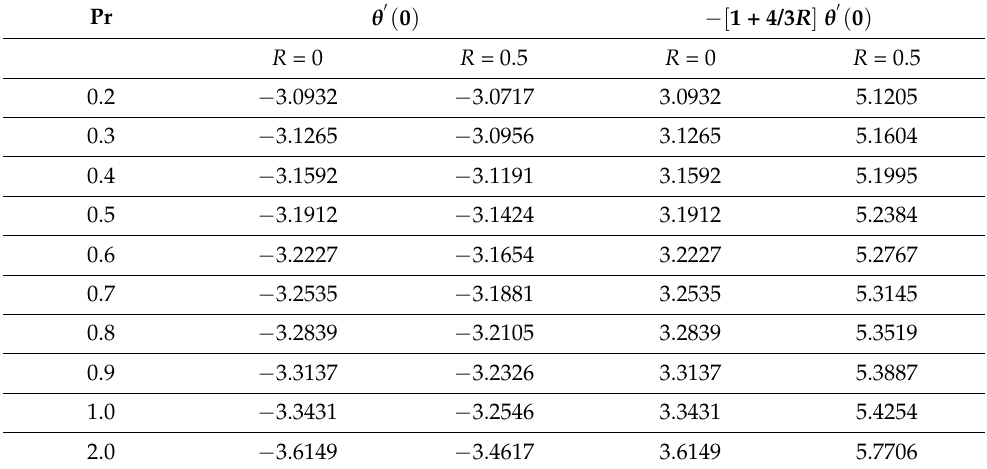
Table 13. Impact of Prandtl number on Nusselt number for non-radiative and radiative flow fields.